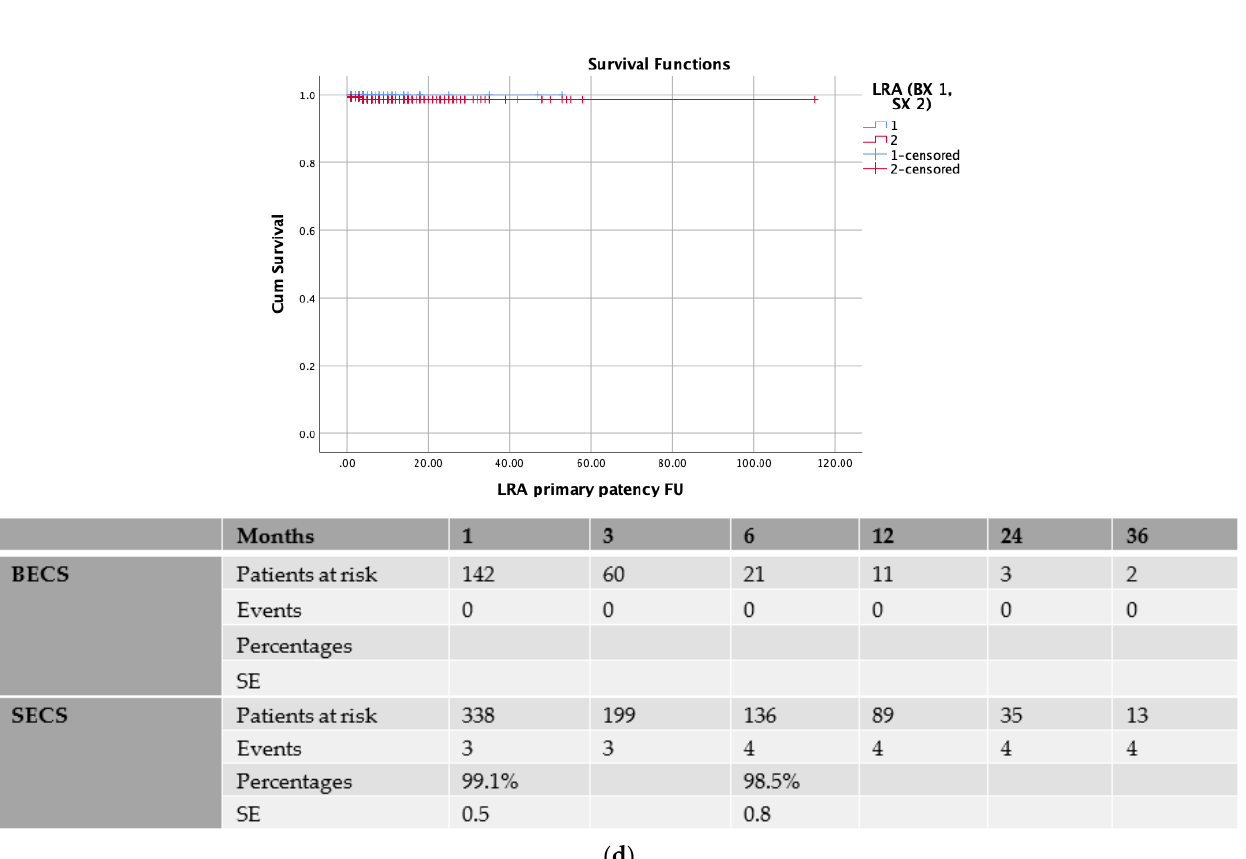
Figure 2. ( a ) Sub-analysis between balloon-expandable covered stents (BECSs) and self-expanding covered stents (SECSs) for primary patency of coeliac trunk (CT) bridging covered stent. SE: standard error; ( b ) Sub-analysis between balloon-expandable covered stents (BECSs) and self-expanding covered stents (SECSs) for primary patency of superior mesenteric artery (SMA) bridging covered stent. SE: standard error; ( c ) Sub-analysis between balloon-expandable covered stents (BECSs) and self-expanding covered stents (SECSs) for primary patency of right renal artery (RRA) bridging covered stent. SE: standard error; ( d ) Sub-analysis between balloon-expandable covered stents (BECSs) and self-expanding covered stents (SECSs) for primary patency of left renal artery (LRA) bridging covered stent. SE: standard error.